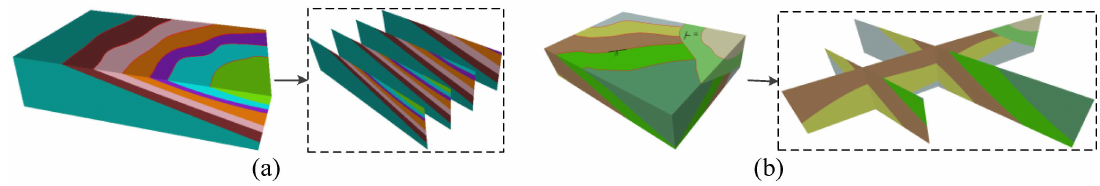
Figure 7. Simulated strata: ( a ) conformable strata and sections perpendicular to the strata and ( b ) unconformable strata and cross-sections describing the conformable and unconformable parts.